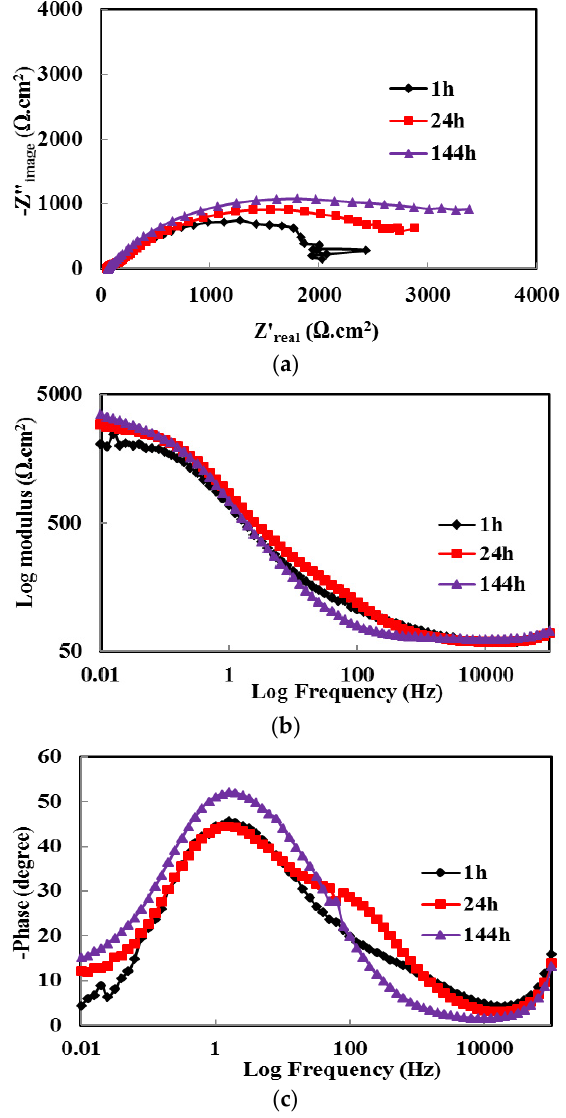
Figure 7. Electrochemical impedance studies of Al coating in SAE J2334 solution with exposure periods ( a ) Nyquist, ( b ) Bode impedance ‐ frequency, ( c ) Bode phase ‐ frequency plots.